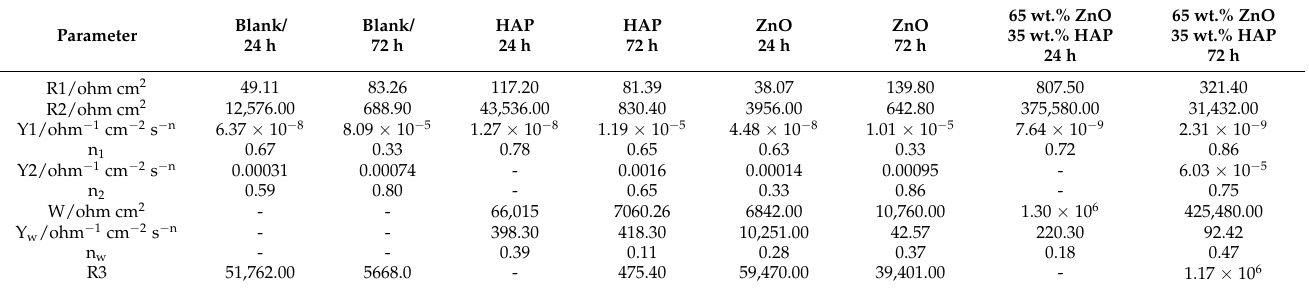
Table 6. EIS parameters of different coated electrodes soaked for 24 and 72 h,